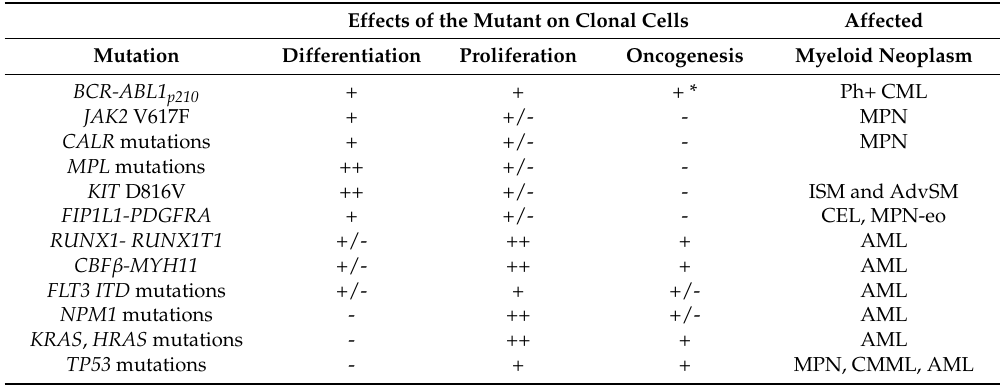
Table 3. Somatic mutations producing clonal hematopoiesis of oncogenic potential (CHOP). Effects of the Mutant on Clonal Cells Affected Mutation